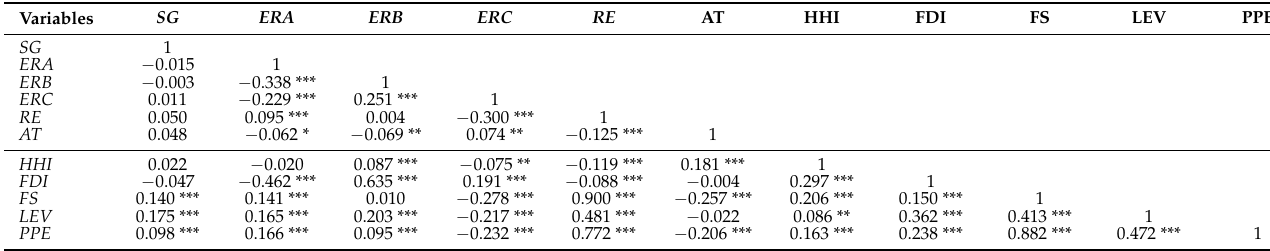
Table 3. Correlation analysis of